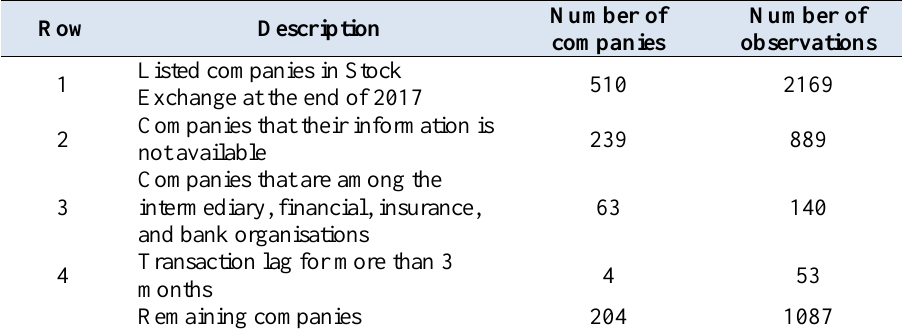
Table 1 . The sample of the